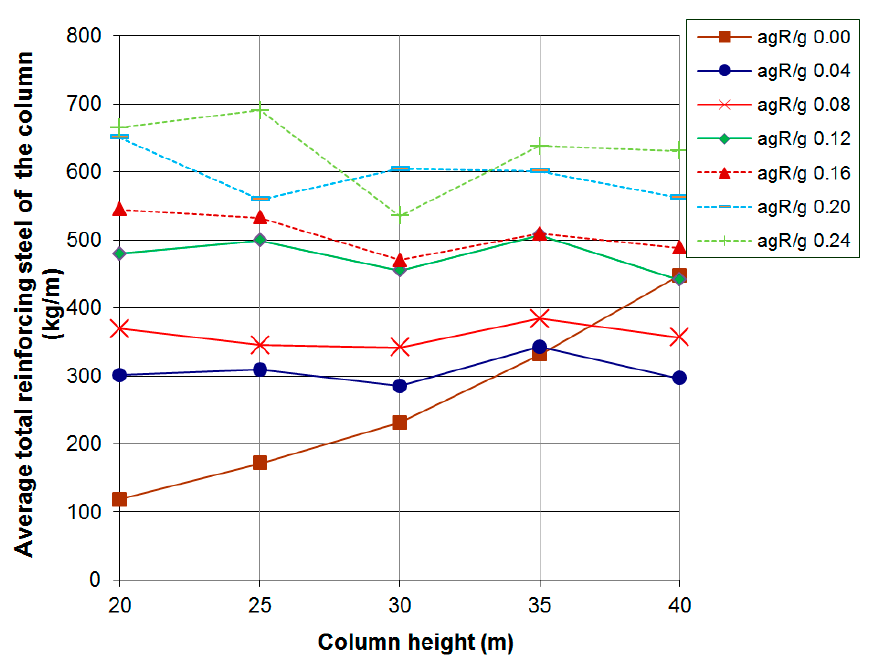
Figure 10. Steel kg/m in the column versus height of the column.